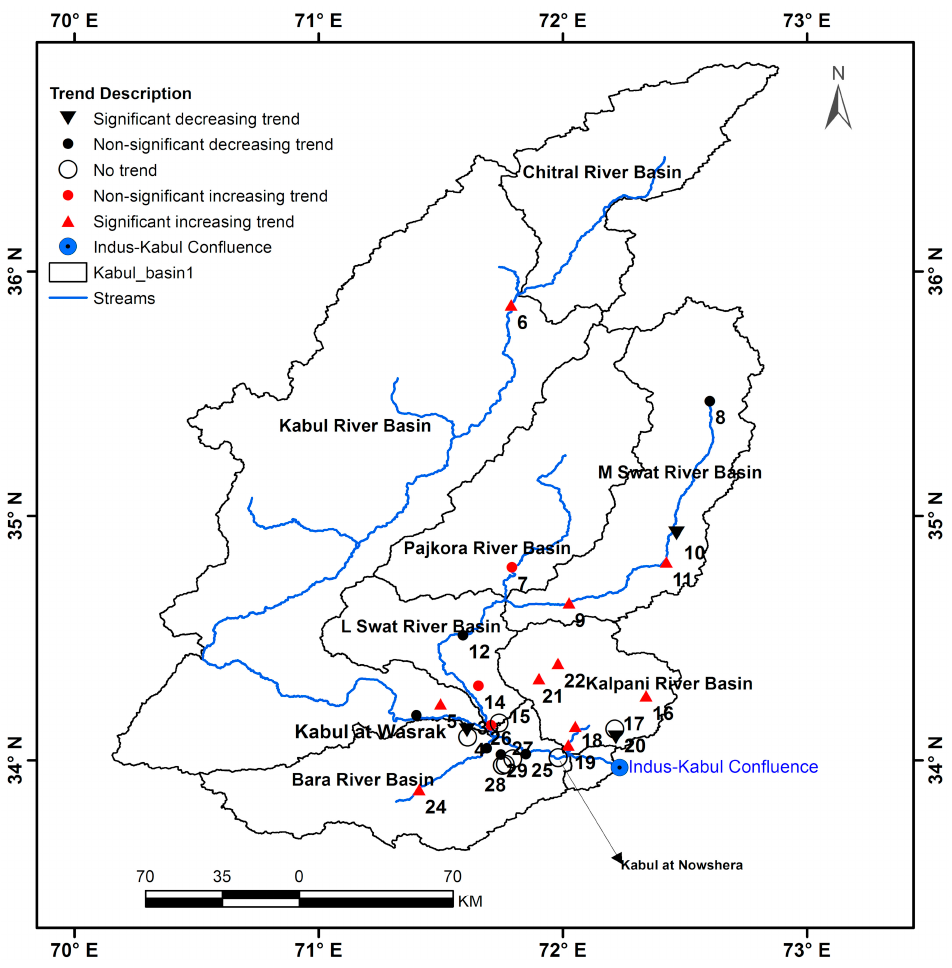
Figure 2. Spatial distribution of trends in the annual maximum flood regime of the KRB, Pakistan.